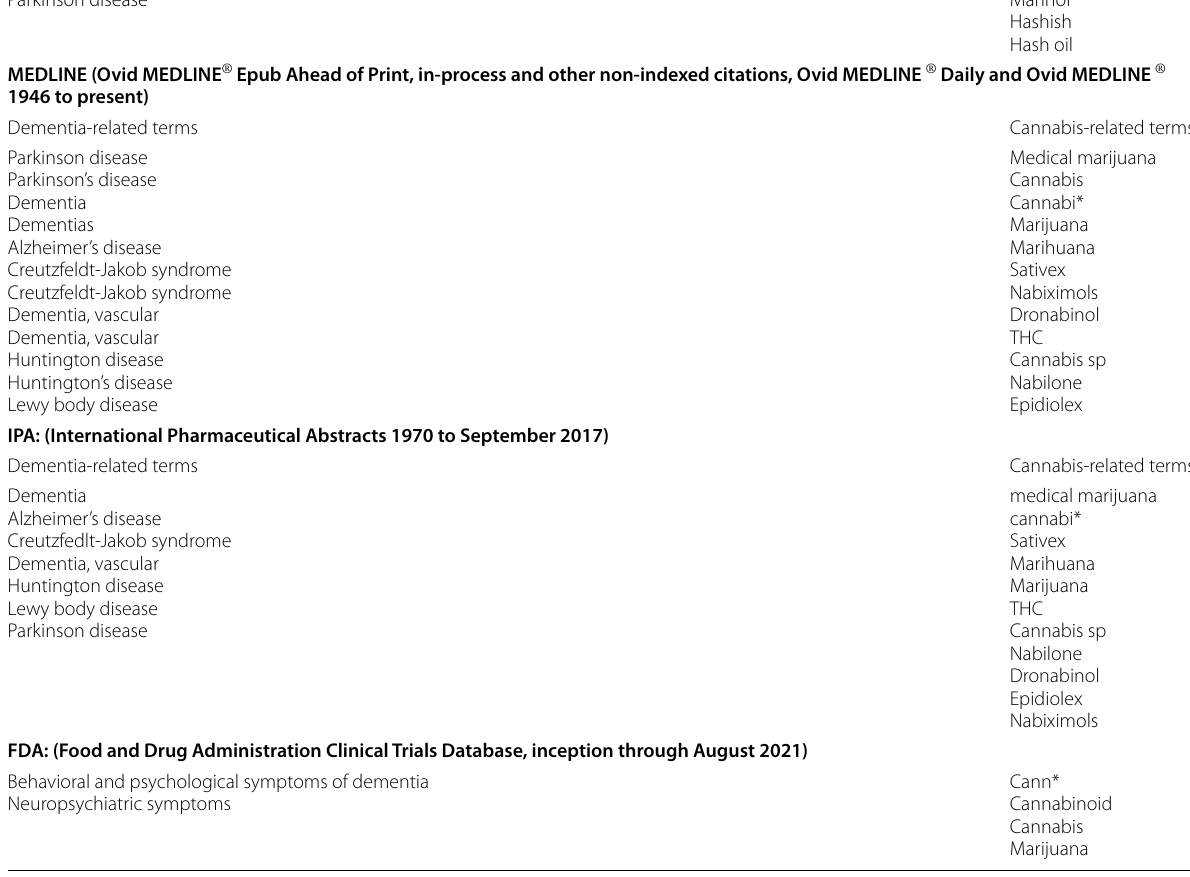
*signifies a truncation command in the search strategy permitting any term that has the text preceding the asterix